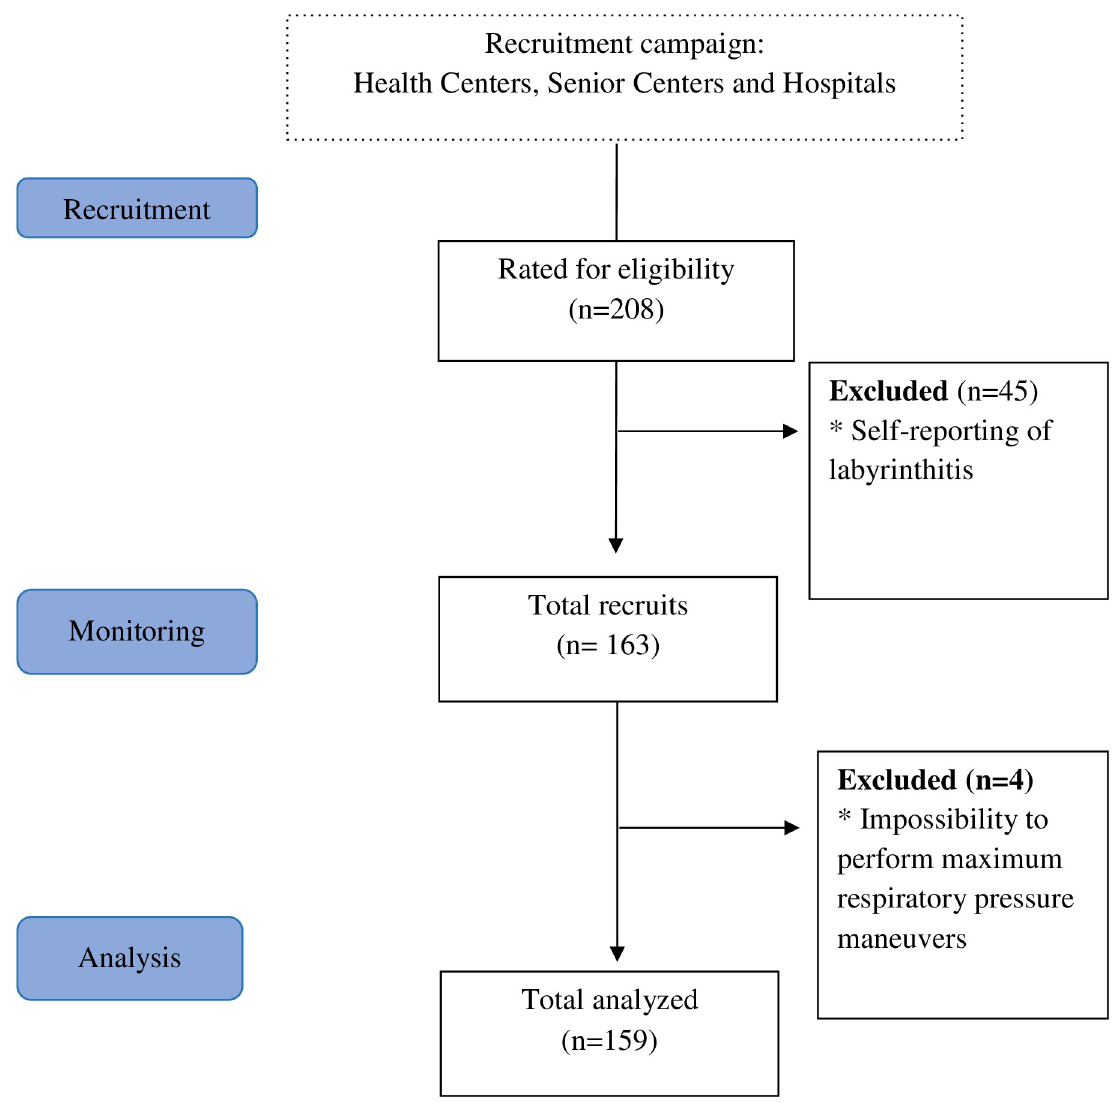
Fig 1. Flowchart explaining the participants progression, from sample recruitment to